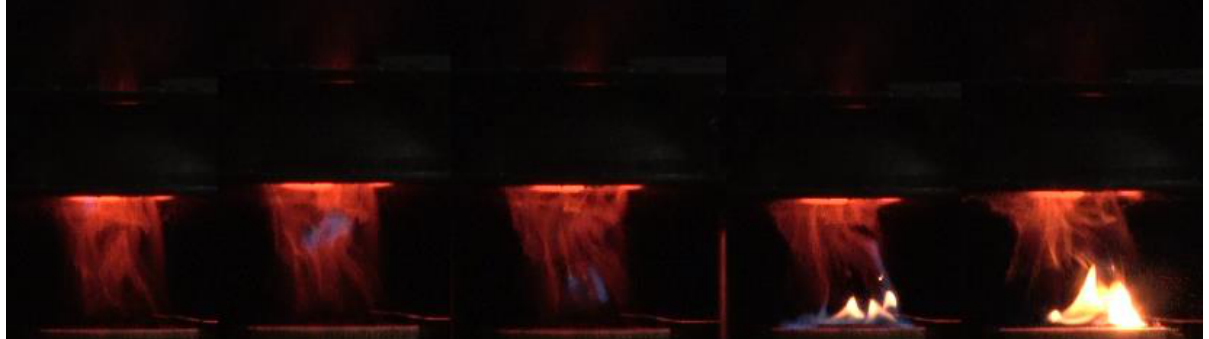
Figure 2. Timelapse images of flaming ignition of the PMMA ( D = 50 mm).